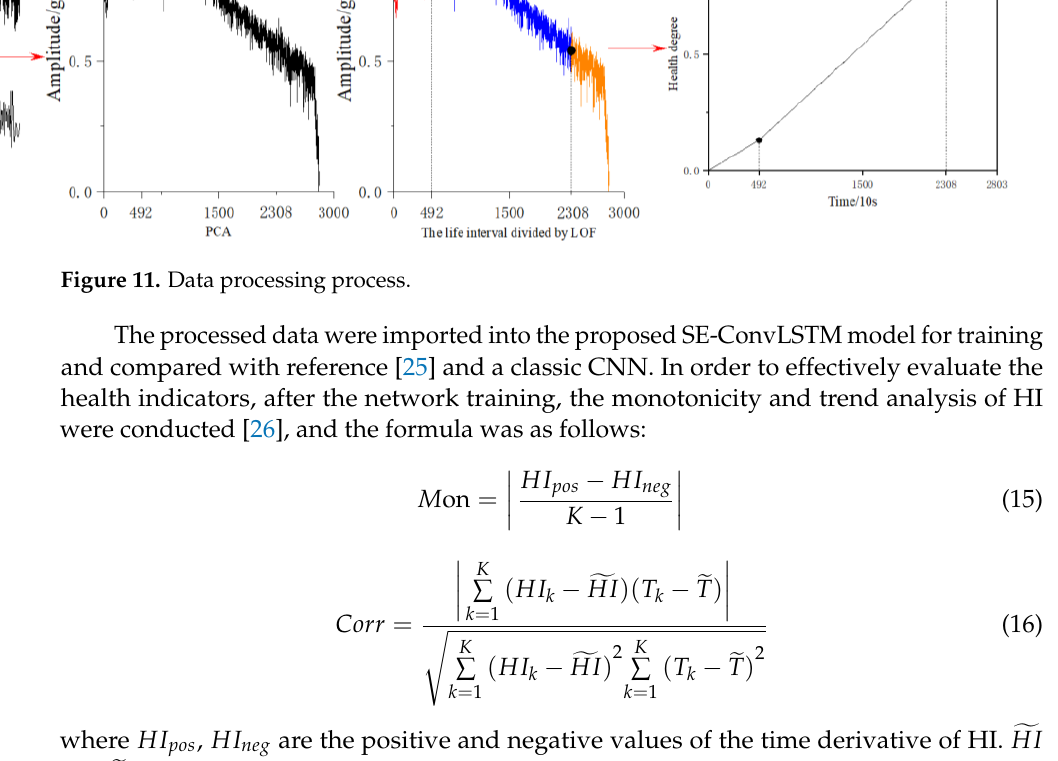
Figure 10. Eleven frequency domain features.